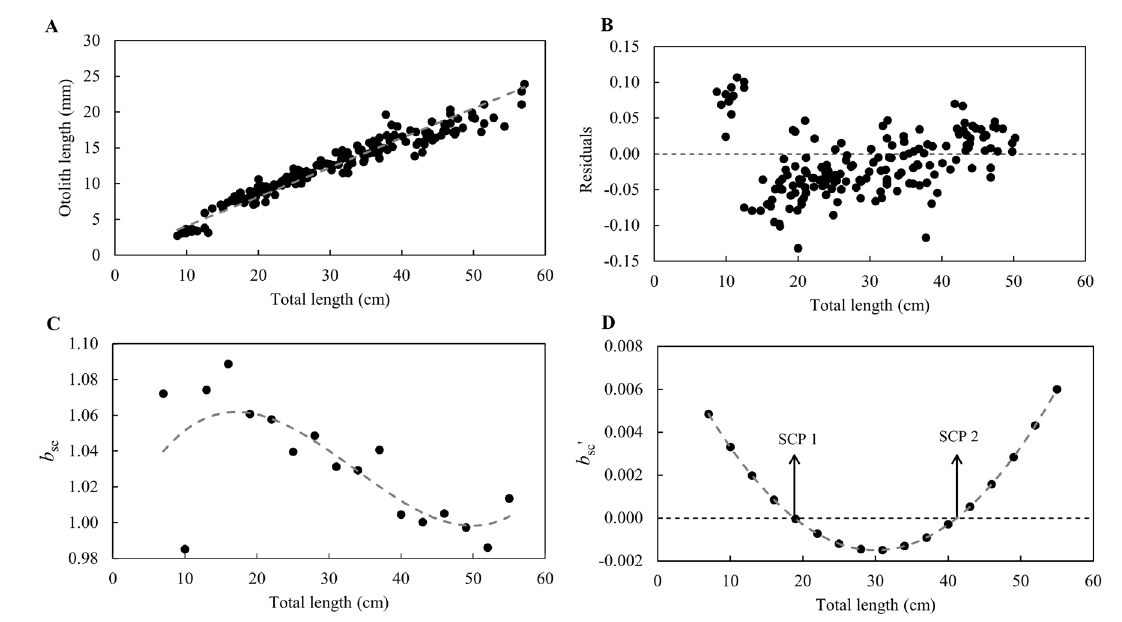
FIGURE 5 | Growth changes in Centropomus parallelus based on a polyphasic growth model. A. Potential regression for fish total length as a function of otolith radius; B. Residual distribution; C. Exponential coefficient ( b sc) for length class; D. Derivative of the third-degree polynomial function, and indication of the change points of the stanza (SCP 1 and SCP 2).